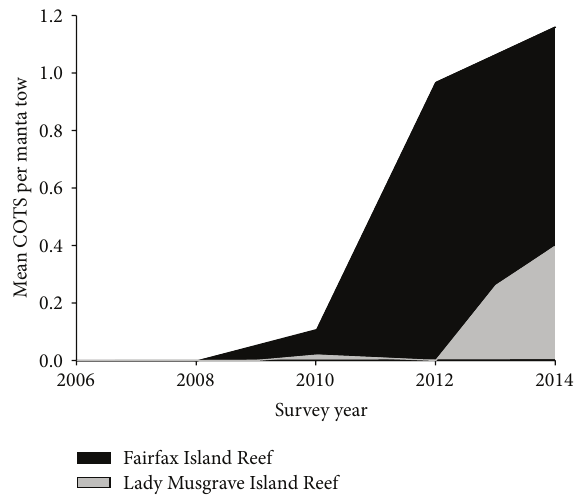
Figure 2: Recent change in abundance of COTS on Fairfax Island Reef (surveyed in 2006, 2008, 2010, 2012, and 2014) and Lady MusgraveIslandReef(surveyedin2006,2007,2009,2010,2012,2013, and 2014). Survey years run from 1 July of the preceding calendar year to 30 June, so, for instance, the 2012 survey year represents data from reefs that were surveyed between July 2011 and June 2012.